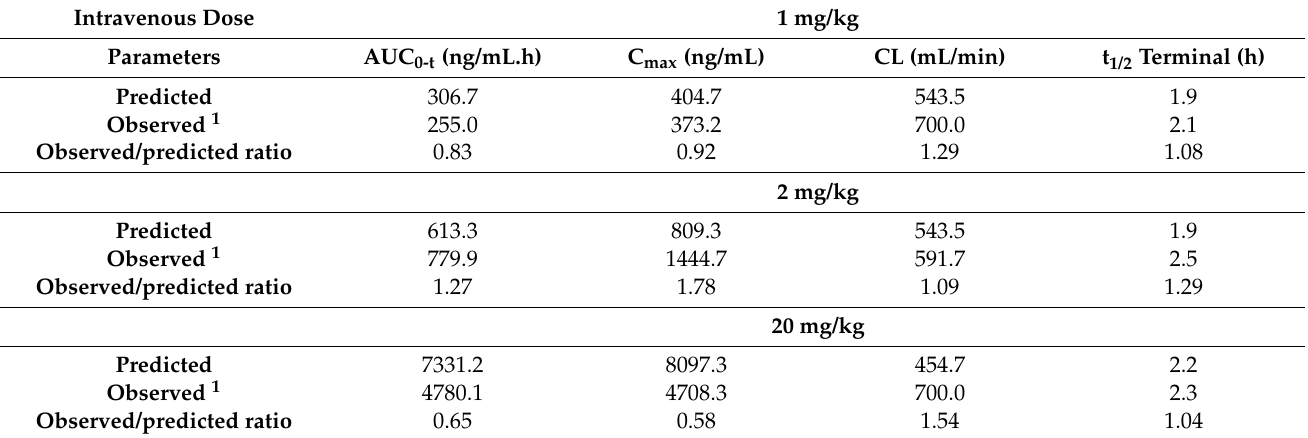
Figure 1. Plasma concentrations versus time plots for dapaconazole after intravenous dose adminis- tration in dogs. The markers represent the observed data in dogs from Palo et al. [7], and the lines represent the predicted mean concentration versus time profiles obtained with the PBPK model. The solid line and triangle markers represent predicted and observed plasma concentrations after a 1 mg/kg dose; the dash-dot line and circle markers represent predicted and observed plasma concentrations after a 2 mg/kg dose; and the dashed line and square markers represent predicted and observed plasma concentrations after a 20-mg/kg dose. Table 5. Prediction performance of the dapaconazole PBPK model in dogs (model qualification).